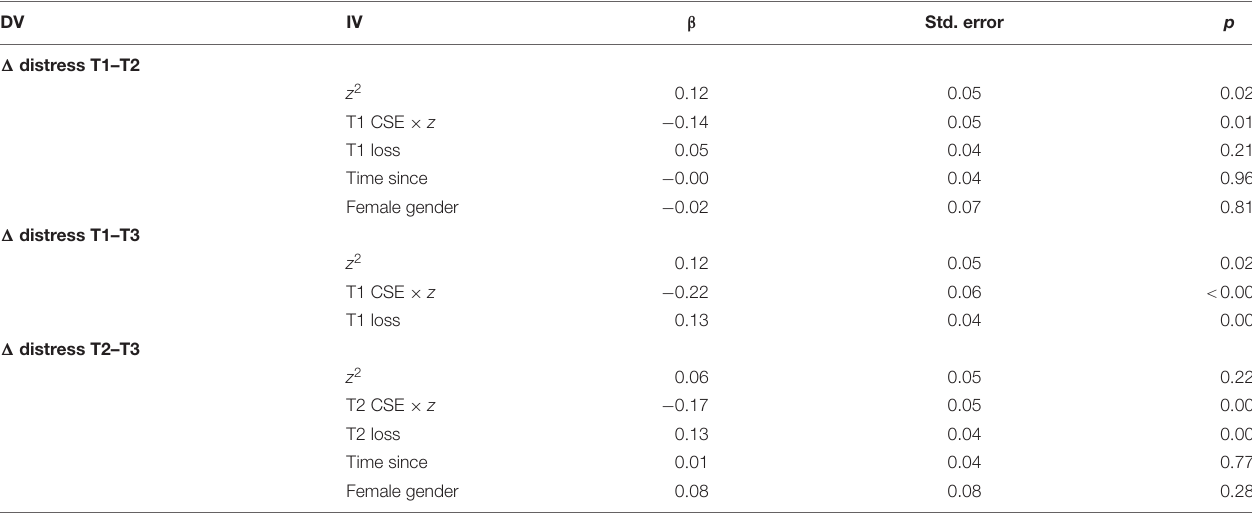
TABLE 2 | Standardized coefficients, standard error, and p -values for the cusp model for Study 1.